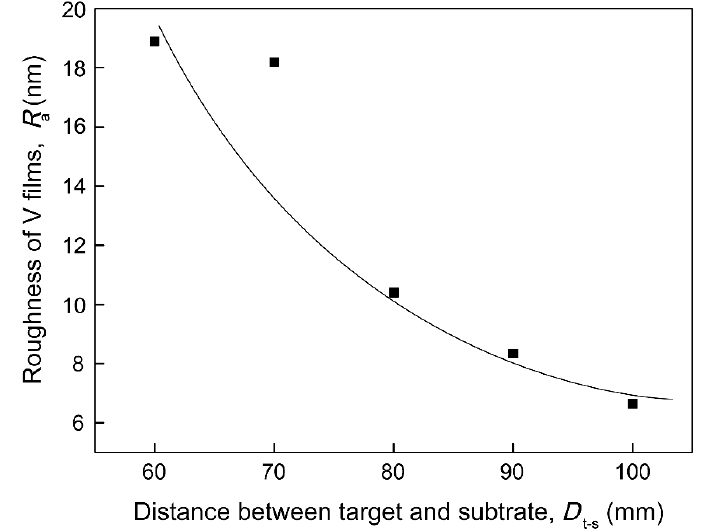
Figure 8. Effects of target-substrate distances ( D t-s ) on the roughness ( R a ) of V films on Si (100).